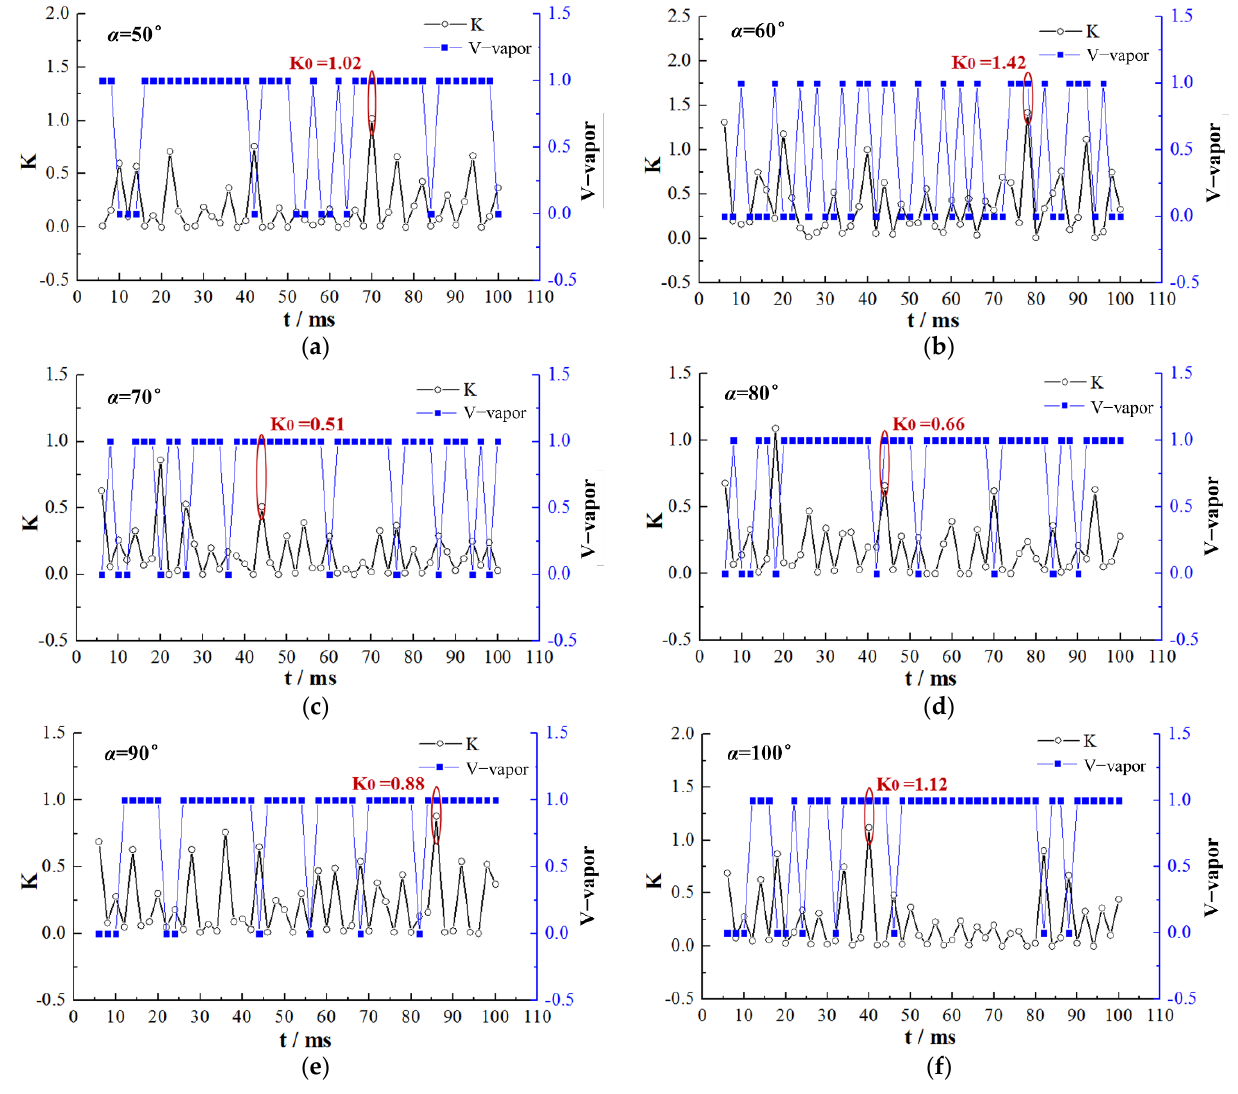
Figure 21. Cavitation numbers of the nozzle at different wall reflection angles. ( a ) α = 50° ( b ) α = 60° ( c ) α = 70° ( d ) α = 80° ( e ) α = 90° and ( f ) α = 100°.